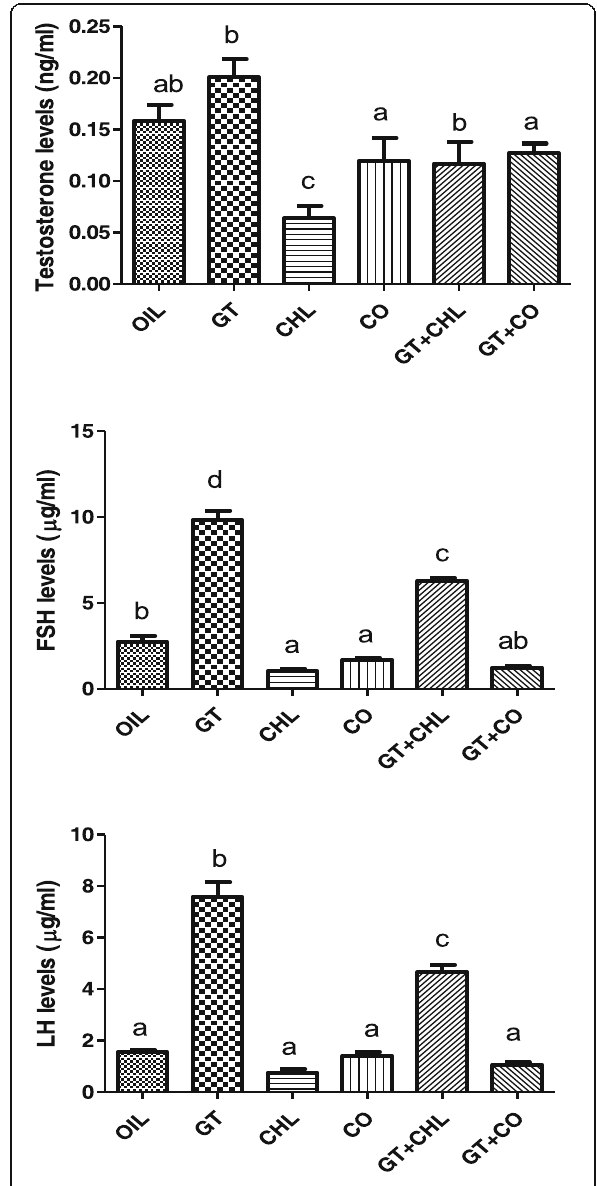
Fig. 5 Serum hormonal levels in Wistar rats treated with mineral oil (OIL), green tea (GT), chlorpyrifos (CHL), an extract of clove oil (CO), green tea and chlorpyrifos (GT+CHL), and green tea and extract of clove oil